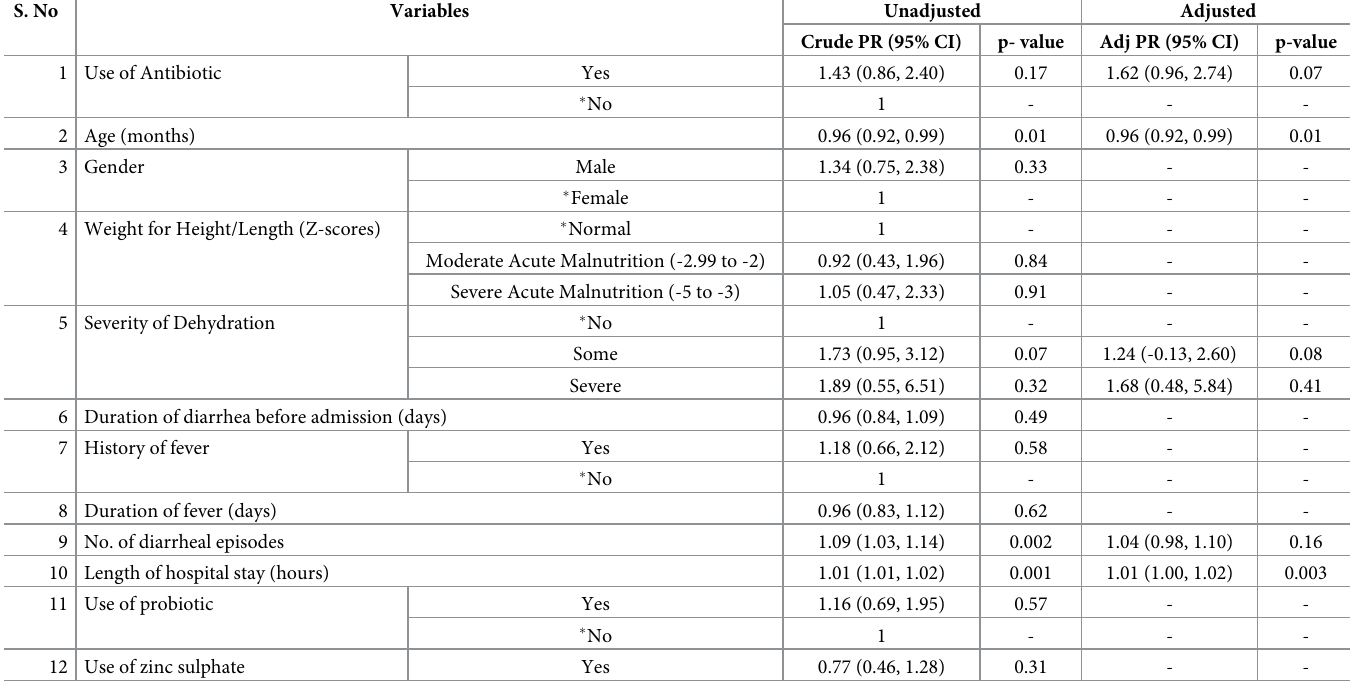
Table 4. Unadjusted and adjusted analysis of clinical characteristics and need of intravenous rehydration after 24 hours of presentation in children presented with acute watery diarrhea in a tertiary care